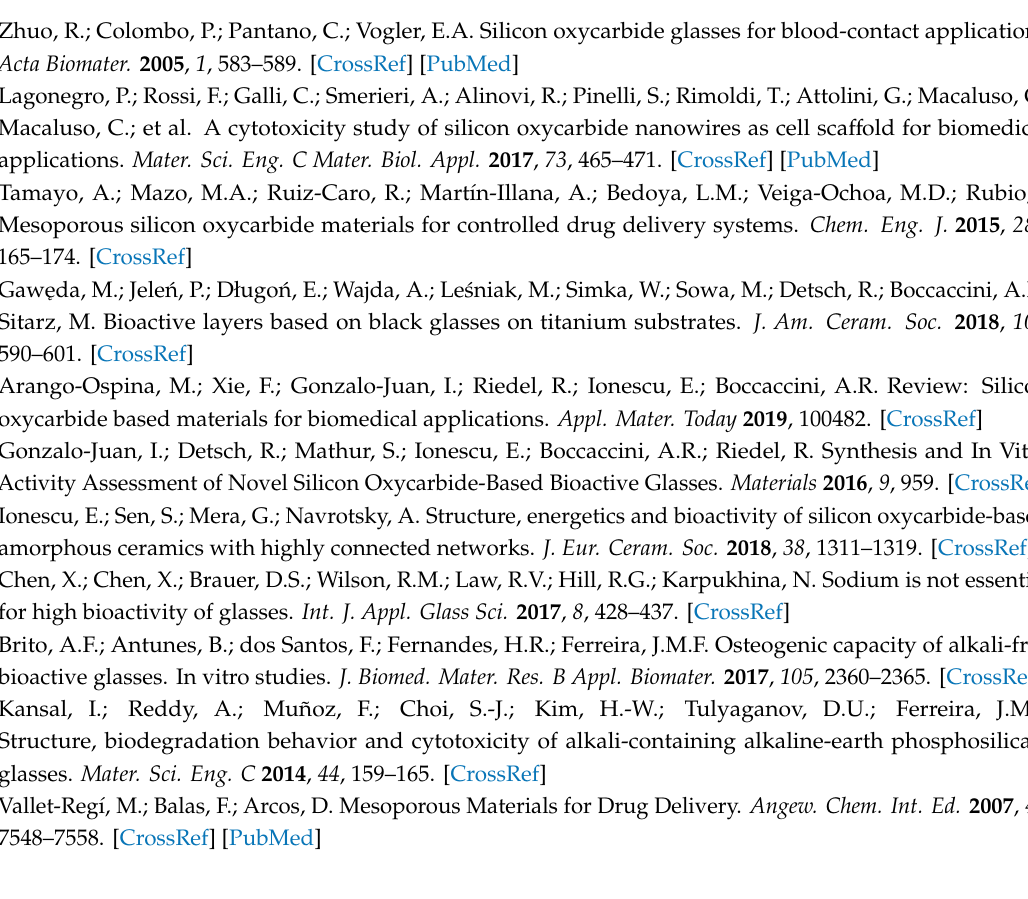
Figure S1: N 2 sorption isotherms of SG-Ca12 and SiCa12 in (a), SG-Ca50 and SiCa50 in (b) and the BJH desorption particle size distribution calculated for SG-Ca12 and SiCa12 in (c) and SG-Ca50 and SiCa50 in